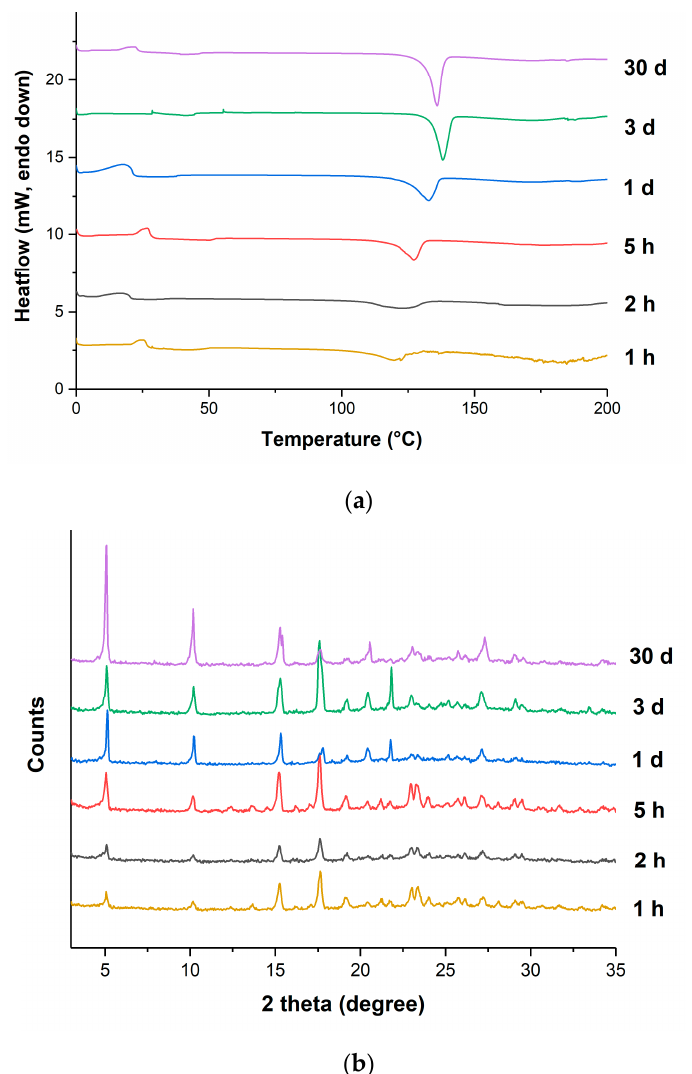
Figure 5. ( a ) DSC thermograms and ( b ) PXRD patterns of the VRC-TAR system at different annealing time points (T anneal = 60 °C).